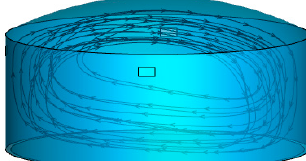
Figure 6. Streamtraces inside the tank for the floating-deck height of 5.63 m.